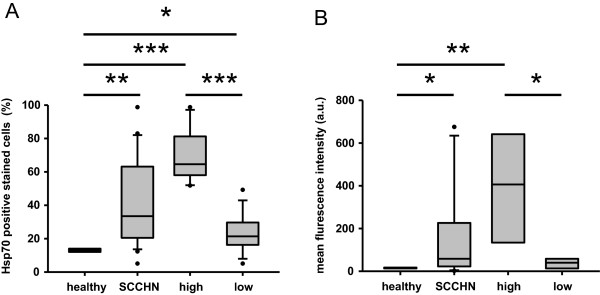
Hsp70 membrane expression on biopsies of SCCHN patients. A. The cells stained with FITC-labeled cmHsp70.1 monoclonal antibody corrected with IgG1 isotype-matched control antibody are depicted in box plots. Data from patients’ tumor cells (n = 21) were divided into low (n = 10) and high (n = 11) mHsp70 expressing cells. Single cells from healthy donors (n = 7) derived from connective tissues were used as controls. B. Mean fluorescence intensity from the same data set as shown in A. Standard box plots are shown with boundaries indicating the 25th and the 75th percentile. The line inside boxes indicates the median and the whiskers indicate the 10th and 90th percentile, respectively. All outliers are included into the graphs. (*p < 0.05, **p < 0.01, ***p < 0.001).